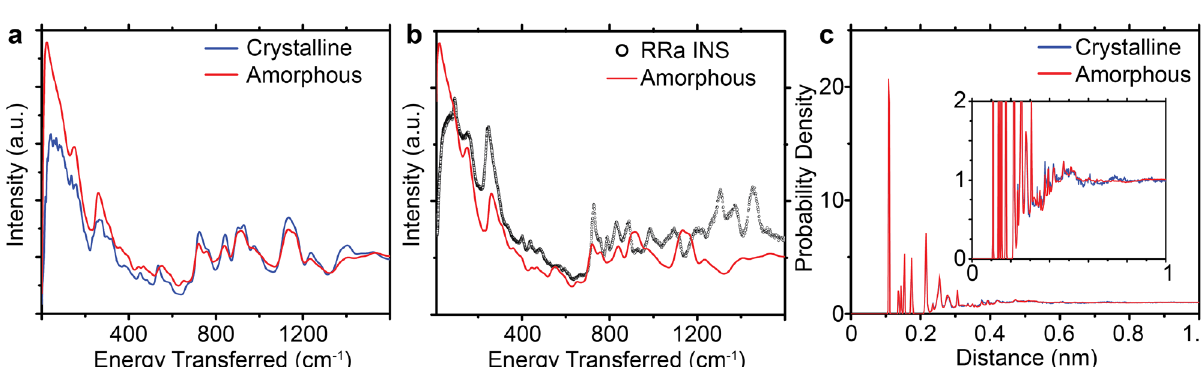
Figure 4. Comparison between MD simulated spectra for crystalline and amorphous P3HT materials. ( a ) Comparison between the MD simulated spectra of the crystalline and amorphous phases. ( b ) Comparison between experimental INS spectrum for regiorandom (RRa) P3HT, and the amorphous MD simulated spectrum. ( c ) Radial distribution functions comparing crystalline and amorphous regions of P3HT; the inset is the same plot expanded at low probability densities to demonstrate the differences between the two distributions. The MD spectrum was convolved by a Gaussian of width 0.01E, where E is the energy